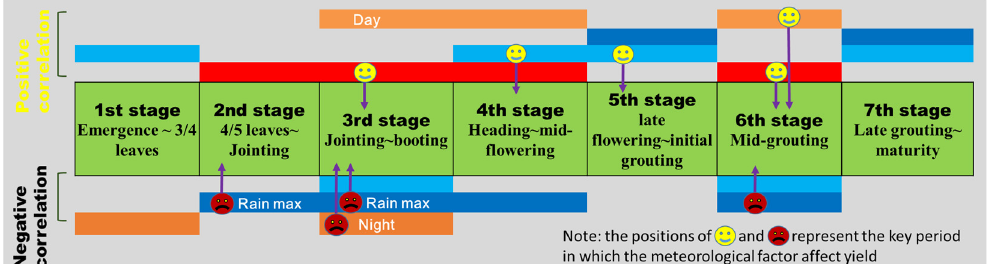
Figure 8. The period and meteorological factors that affect summer millet yield. The green squares represent the growth period of summer millet, with the factors positively related to yield shown above the green squares and the factors negatively related to yield displayed below the green square. Red, orange, light blue, and dark blue bars represent sunshine time, air temperature, air humidity, and rainfall, respectively, and the positions of the face symbol represent the key period in which the meteorological factor affects yield.